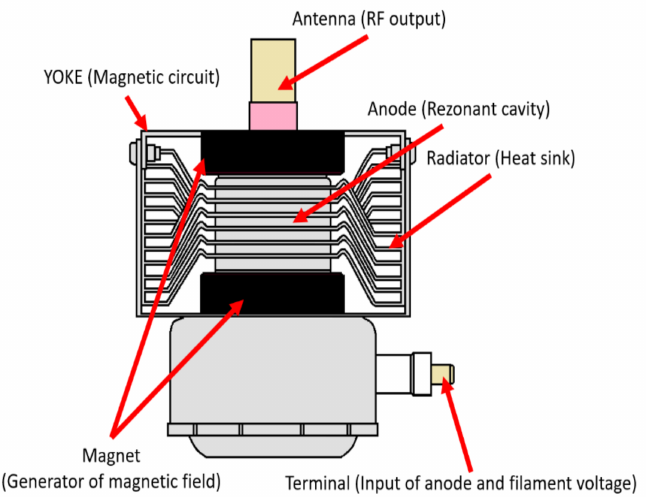
Figure 2. Magnetron used in a microwave power generator (Type 2M119J).